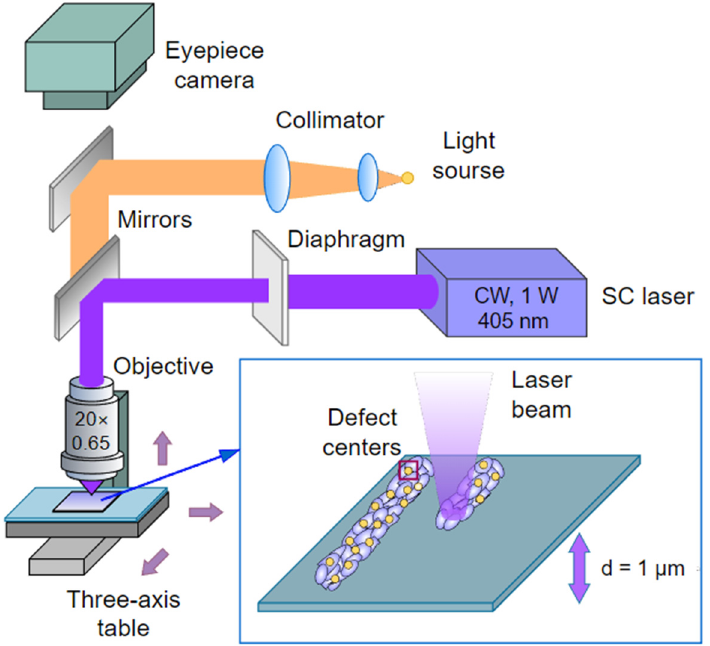
Figure 1. Diagram of an experimental setup scheme for laser modification of the structure of chal- cogenide films using continuous radiation.